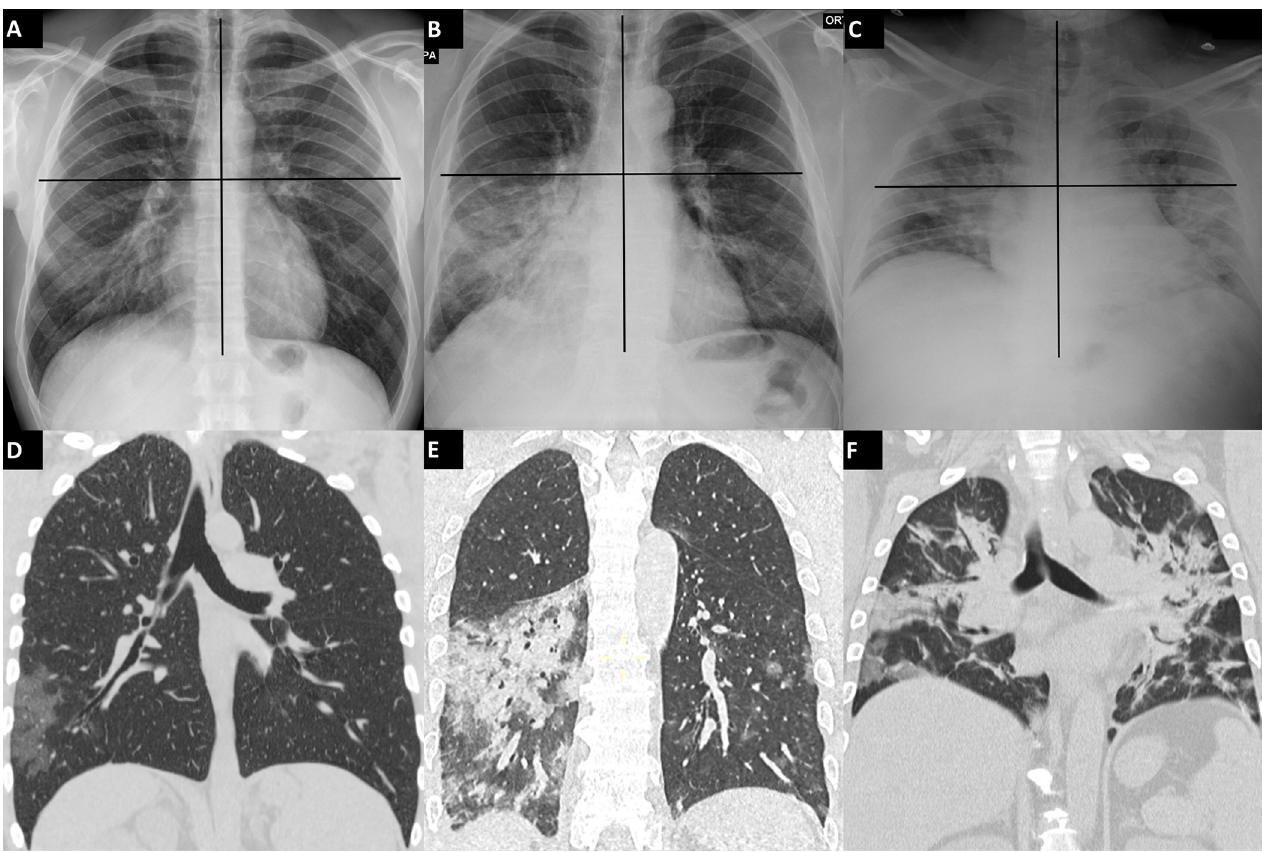
Fig 2. Example of RALE scores and respective CT. Examples of Radiographic Assessment of Lung Edema (RALE) on chest X-rays (CXR) which were divided into quadrants (A, B, C) and correlation with coronal reconstruction of chest computed tomography (CT) performed within 24 hours (D, E, F). Patient 1 (male, 37 y/o) was attributed a RALE score of 7 because of the presence of moderate alveolar opacities in 50/75% of the right inferior quadrant and hazy alveolar opacities in < 25% of the left inferior quadrant (A); chest CT demonstrated the presence of GGO in the right lower lobe and a small area of GGO in the left lower lobe (visual score 10%) (D). Patient 2 (male, 53 y/o) had a RALE score of 19 due to dense alveolar opacities in > 75% of the right lower quadrant, moderate alveolar opacities in 50/75% of the left lower quadrant, and hazy alveolar opacities in < 25% of the left upper quadrant (B); chest CT demonstrated the presence of extensive parenchymal consolidation of the left lower lobe and small areas of GGO in the right lung (visual score 30%) (E). Patient 3 (male, 45 y/o) was attributed a RALE score of 36 because of the involvement of > 75% of every quadrant, with dense opacities in the left lower quadrant and moderate opacities in the remaining three quadrants (C); chest CT demonstrated bilateral consolidations (visual score 60%)